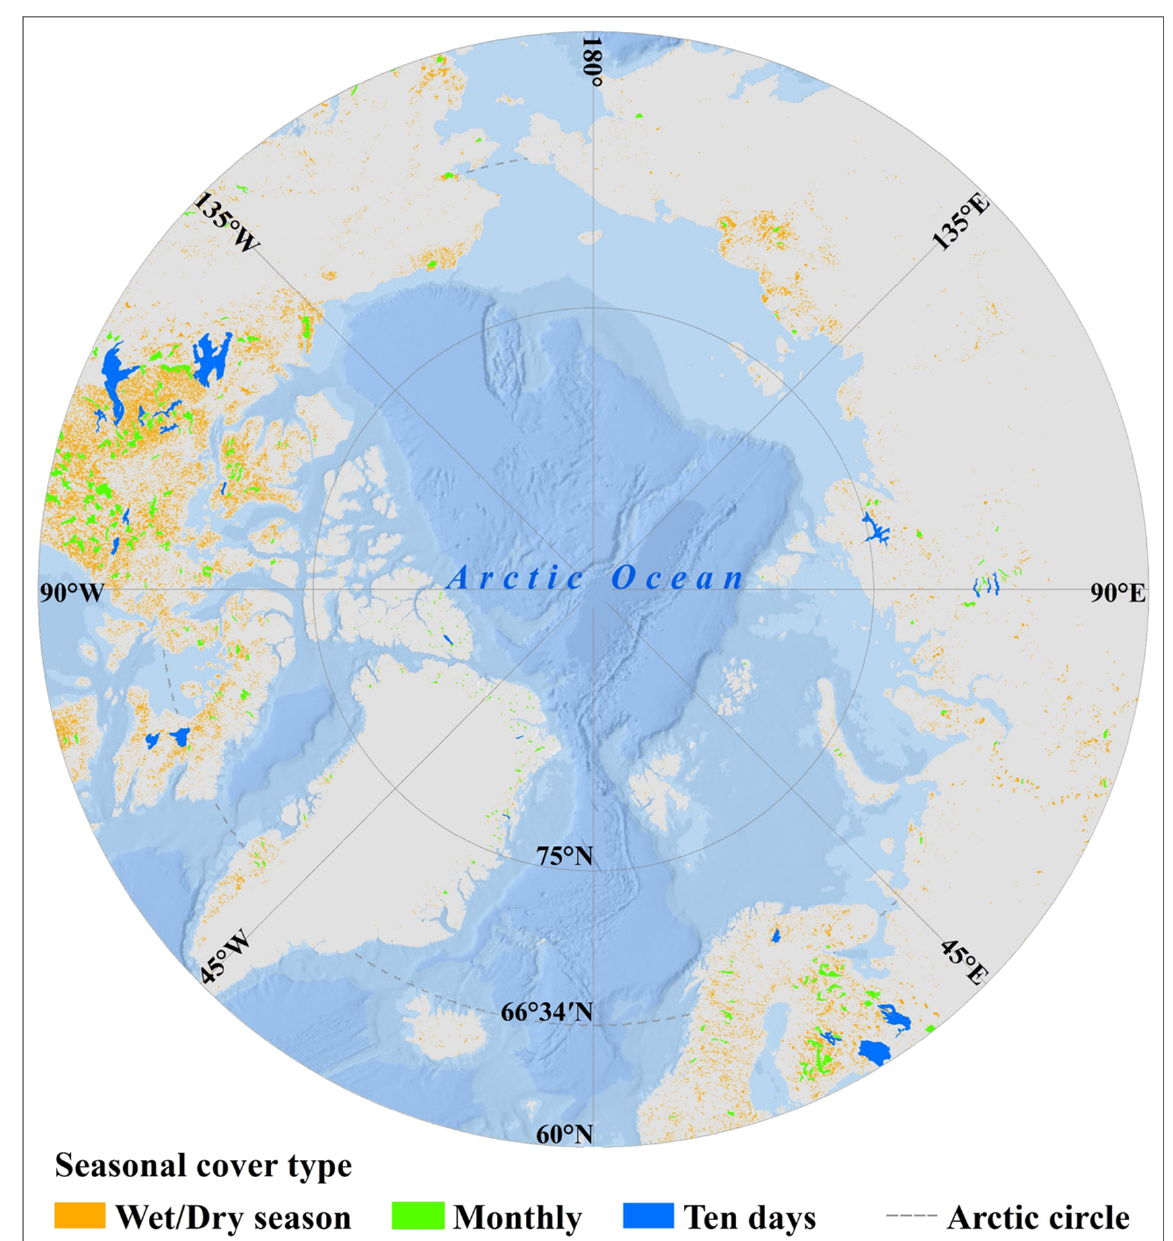
Figure 4. Spatial patterns of observed lakes with seasonal coverage patterns. Table 2. Seasonal observation of lakes of different sizes.